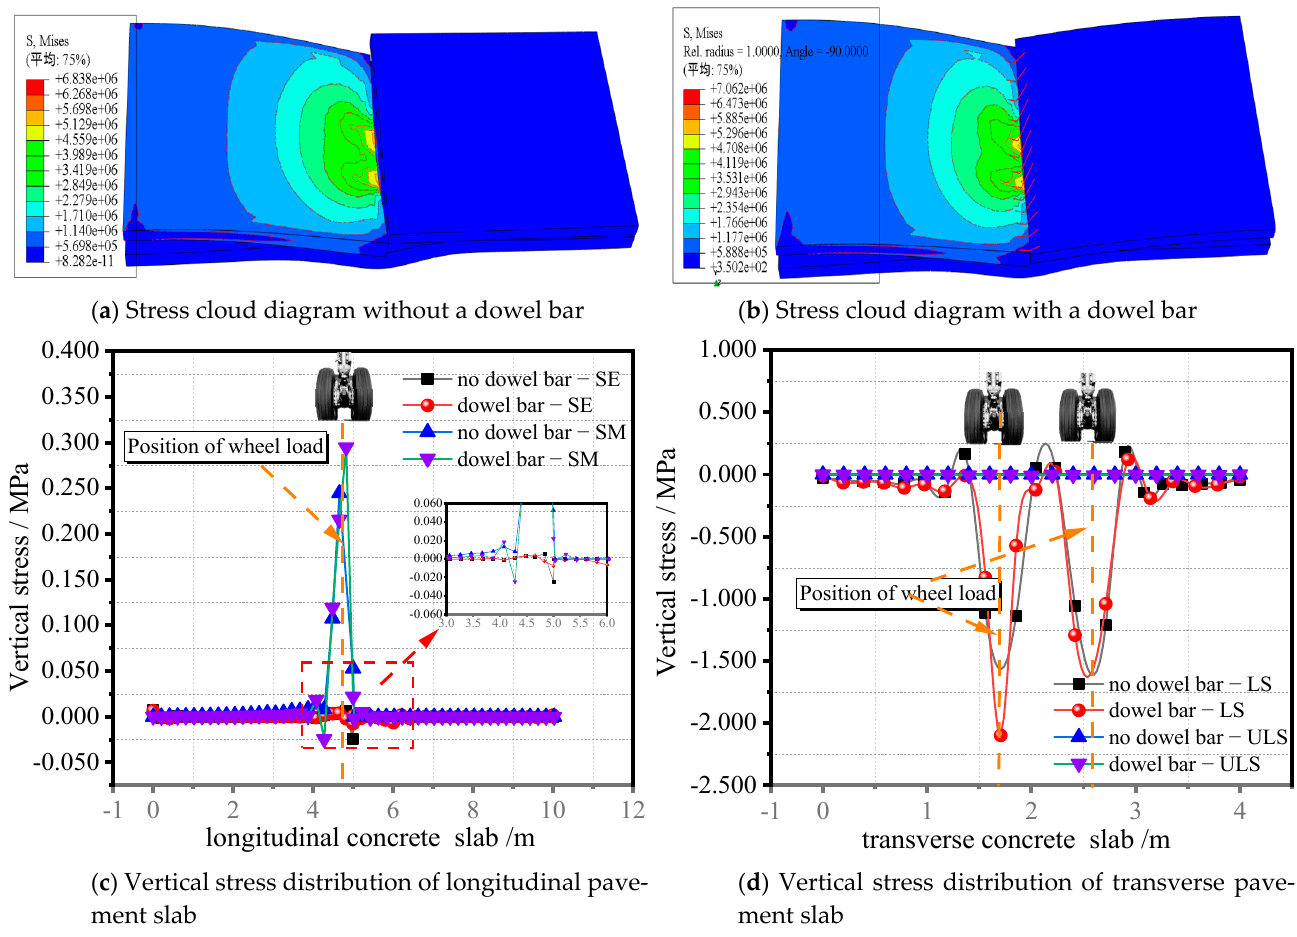
Figure 8. Stress distribution of the aircraft’s wheel load acting on the edge of adjacent slabs. When the aircraft wheel load operates on the edge of the adjacent slab, the maximum vertical displacement of the slab is approximately 1.92 mm, with or without a dowel bar, and the maximum vertical displacement of the slab edge is 0.42 mm. Along the transverse direction of the slab, the vertical displacement from the slab’s center to its edge reduces by 78.13%. The vertical displacement along the longitudinal axis of the slab diminishes parabolically to zero, and the upward warping deformation occurs 2.65 meters away, on the opposite side of the slab. As can be seen from Figure 9, the positioning of the dowel bar has a minimal impact on the stress and deformation of the slab; however, on the sides of the unloaded slab, the vertical displacement increases by 0.52 mm when a dowel bar is present, and the deflection load transfer coefficient is 27.08%.